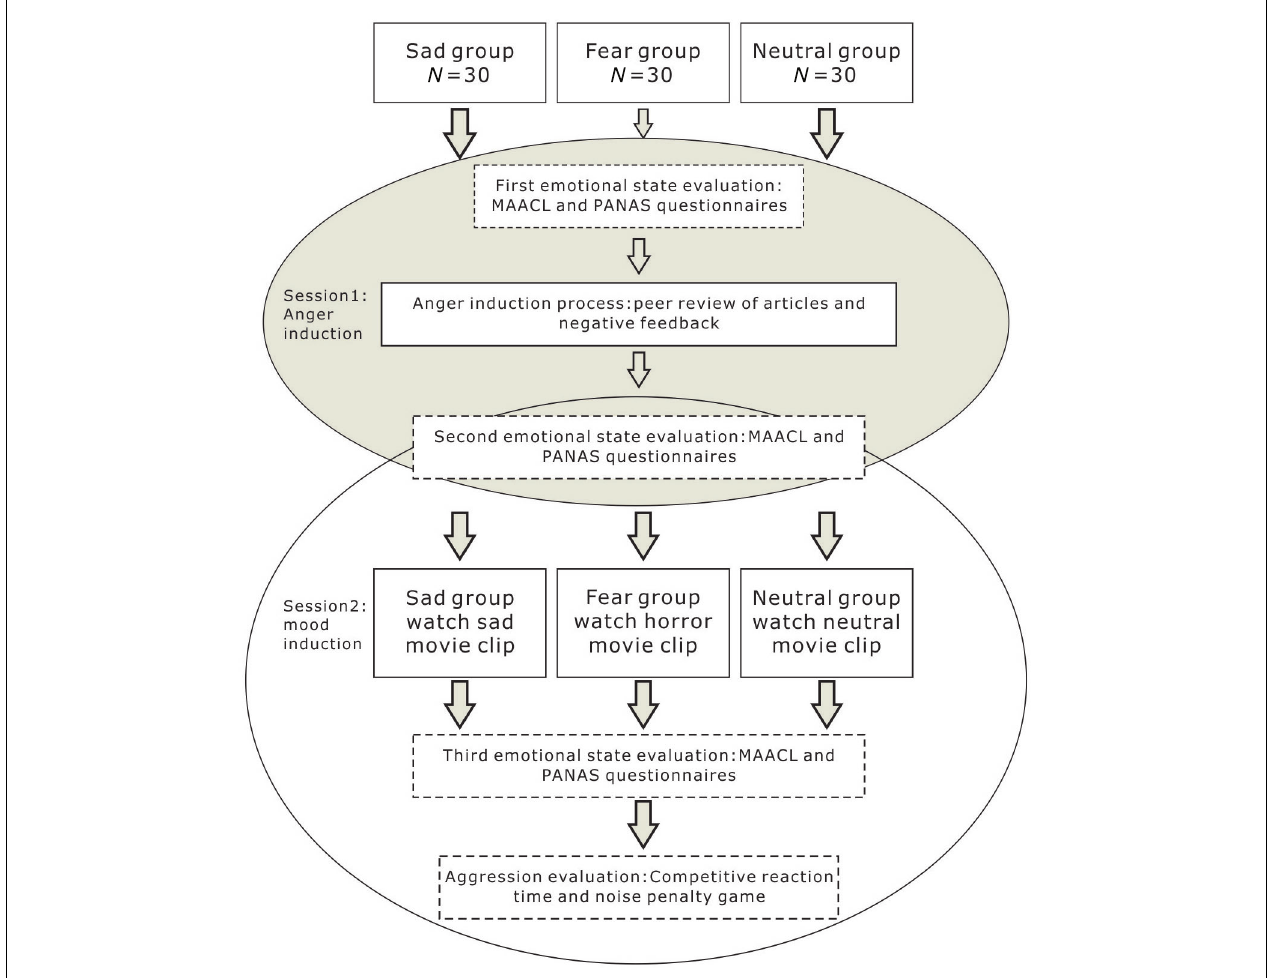
FIGURE 2 | Schematic illustration of the experimental procedure in Study 1. The procedure of Study 2 was the same except that participants watched anger-inducing movie clips in the anger induction